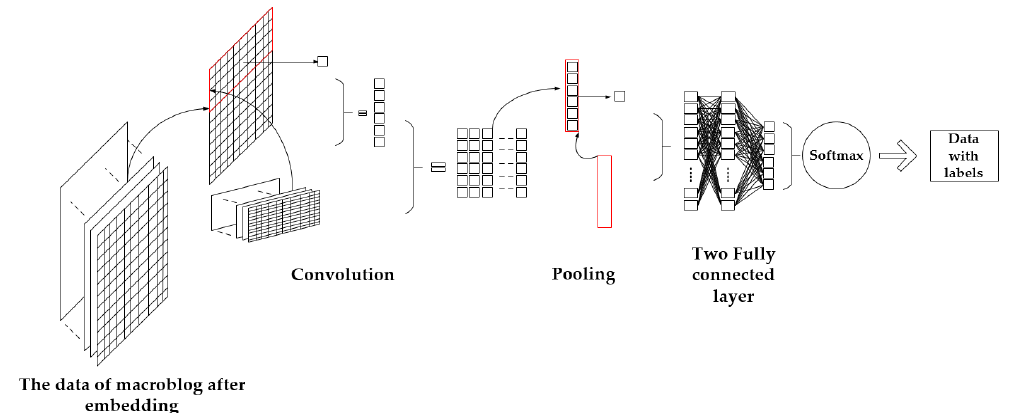
Figure 3. Neural network structure.